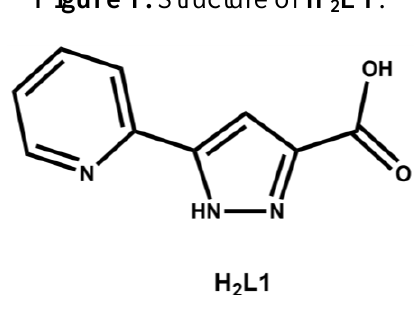
Figure 1. Structure of H